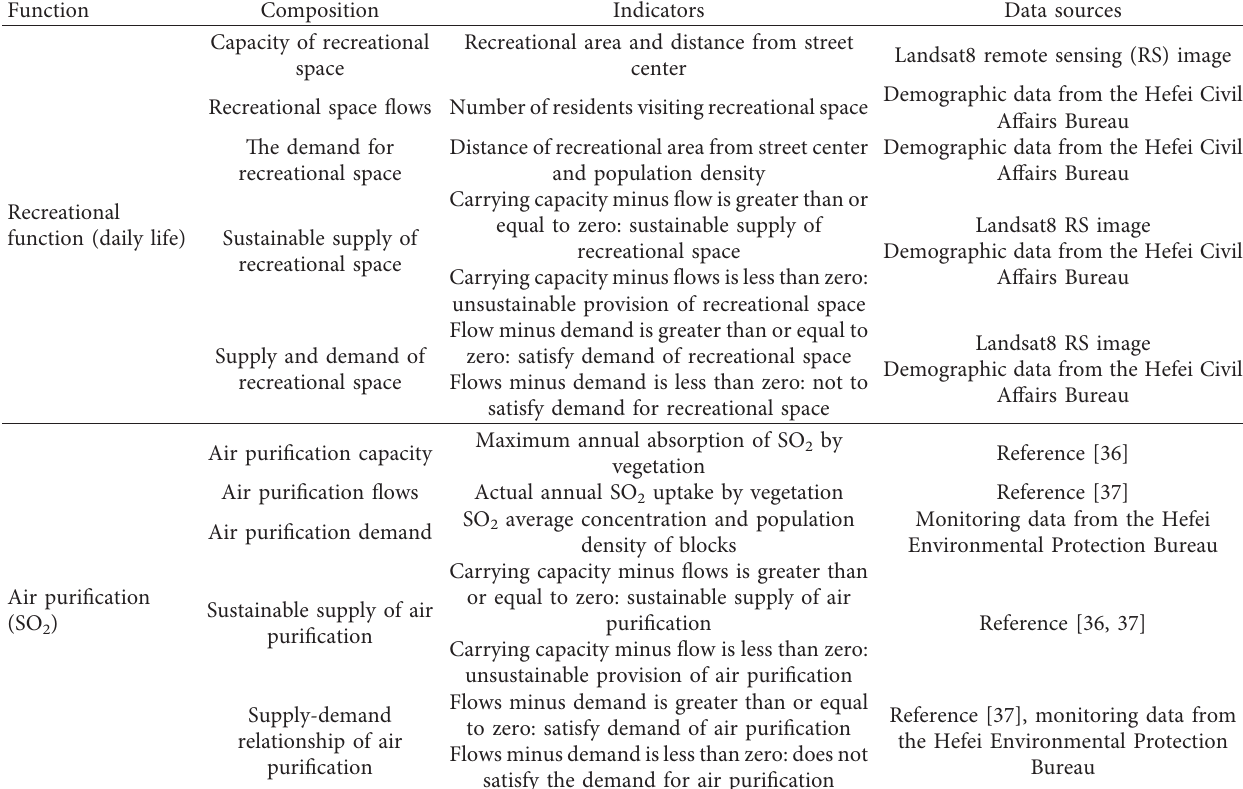
Table 1: Standards and data used to evaluate ecosystem service